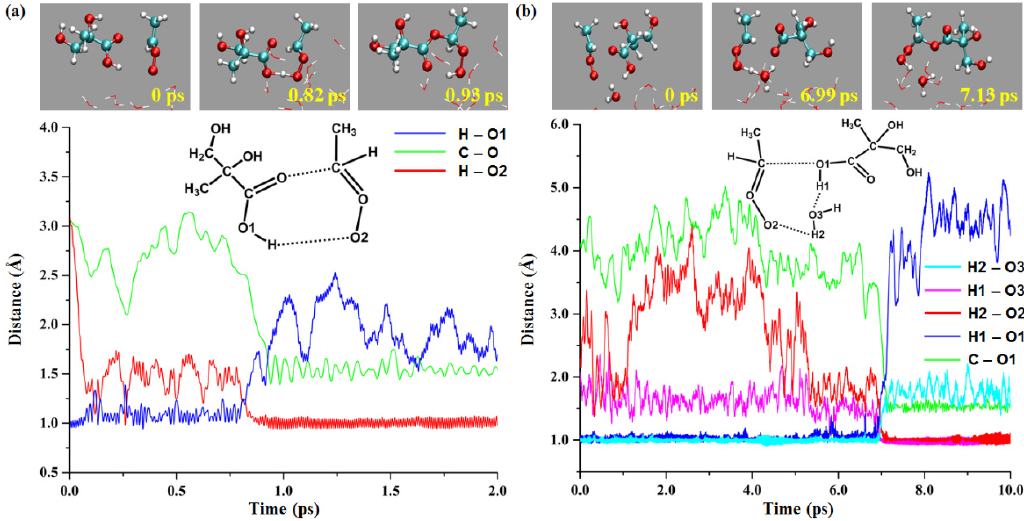
Figure 4. The direct and water-mediated reaction processes of anti -CH 3 CHOO with MGA COOH group at the gas-liquid interface ( a ): direct reaction, ( b ): water-mediated reaction.